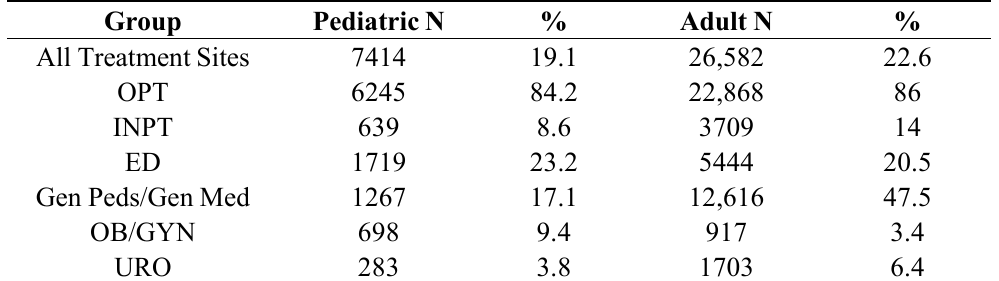
Table 2. E. coli positive urinary cultures by clinical site (N = number, OPT =